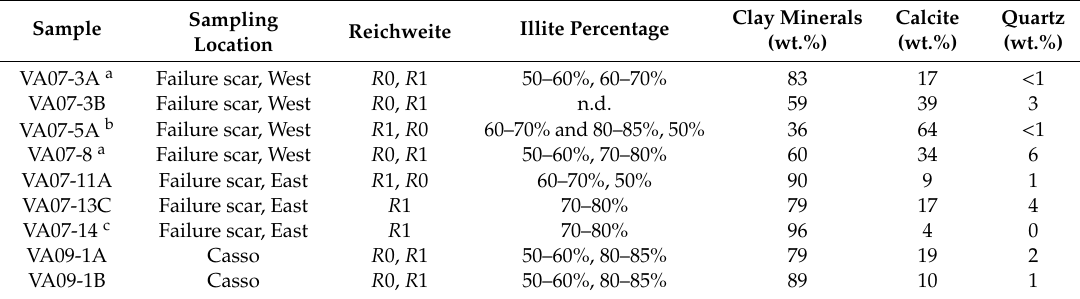
Table 2. Mineralogical composition of clay samples from